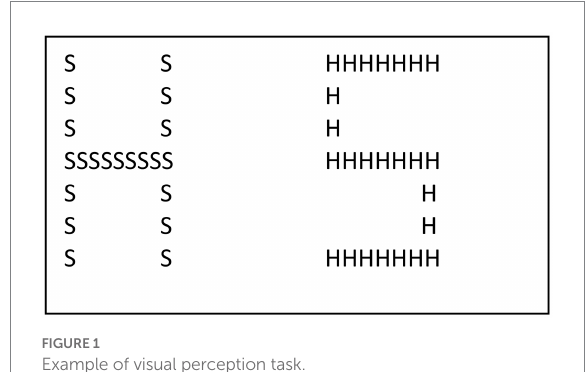
FIGURE 1 Example of visual perception